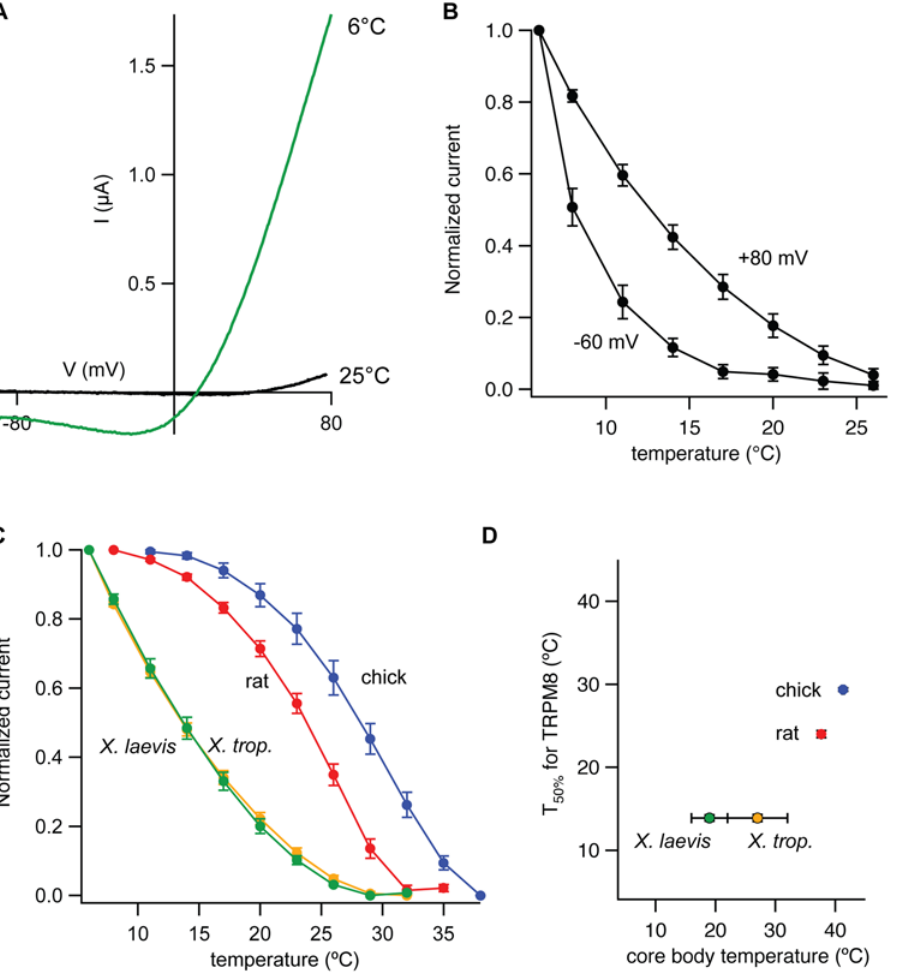
Figure 3. Cloned Xenopus TRPM8 channels show alterations in thermosensitivity compared to their mammalian and avian counterparts. ( A ) Current-voltage relation from a two-electrode voltage clamp recording of xlTRPM8-expressing oocytes under basal or cold- stimulated conditions. Note the strong outward rectification of the cold-evoked current. ( B ) Normalized inward ( 2 60 mV) and outward ( + 80 mV) cold-evoked currents for xlTRPM8. The current obtained at a given temperature was normalized to the maximum cold-evoked current (obtained at 6 u C) obtained at each potential. ( C ) Normalized current-temperature plots (at + 80 mV) for chicken (blue), rat (red), X. laevis (green) and X. tropicalis (orange) TRPM8, yielding half-maximal activation temperatures of 29.35 6 0.21 u C (chicken), 24.00 6 0.43 u C (rat), 13.89 6 0.39 u C ( X. laevis ), and 13.90 6 0.44 u C ( X. trop. ). ( D ) Plot of species core body temperature (obtained from previously published measurements) versus experimentally determined temperature of half-maximal TRPM8 cold activation. Core temperatures were based on previously published values (for Xenopus , core temperatures were estimated as the arithmetic mean and error bars indicate the full range of tolerated temperatures) [14,18,19].